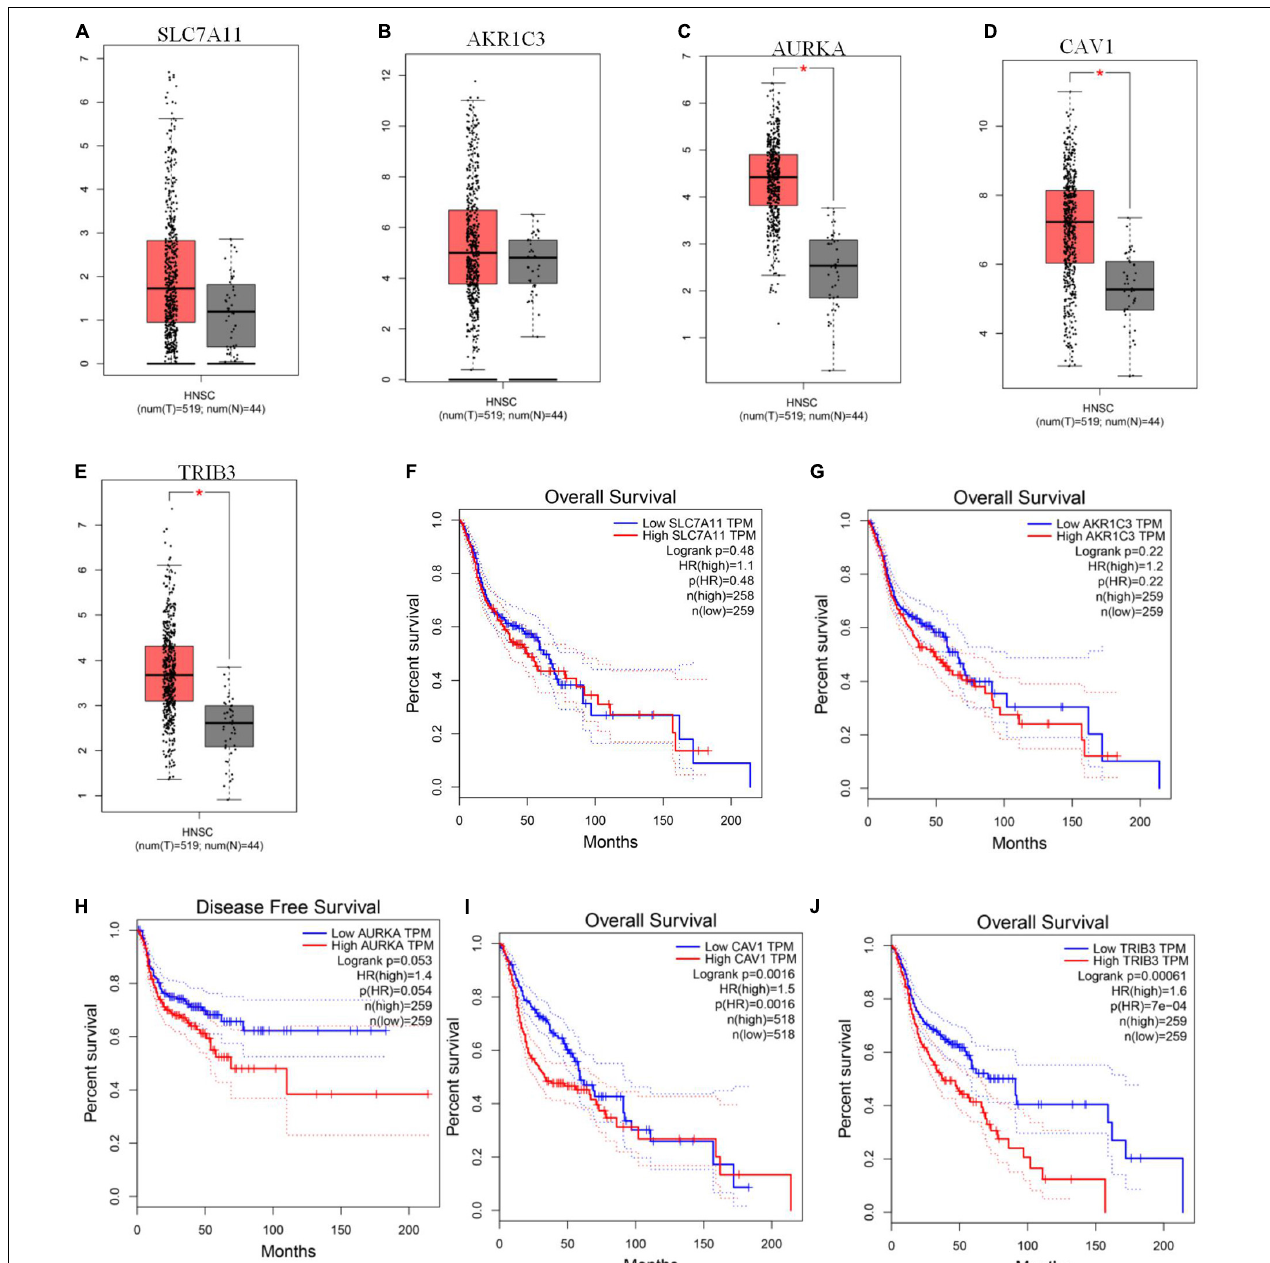
FIGURE 5 | GEPIA verification of ferroptosis-related gene (FRG) expression levels and their relationship with prognosis. (A–E) Expression levels of SLC7A11 , AKR1C3 , AURKA , CAV1 , and TRIB3 . (F–J) Kaplan-Meier curves for OS or disease-free survival based on the five FRGs. TRIB3 and CAV1 are significantly related to OS, AURKA is closely related to patient disease-free survival ( P < 0.05).